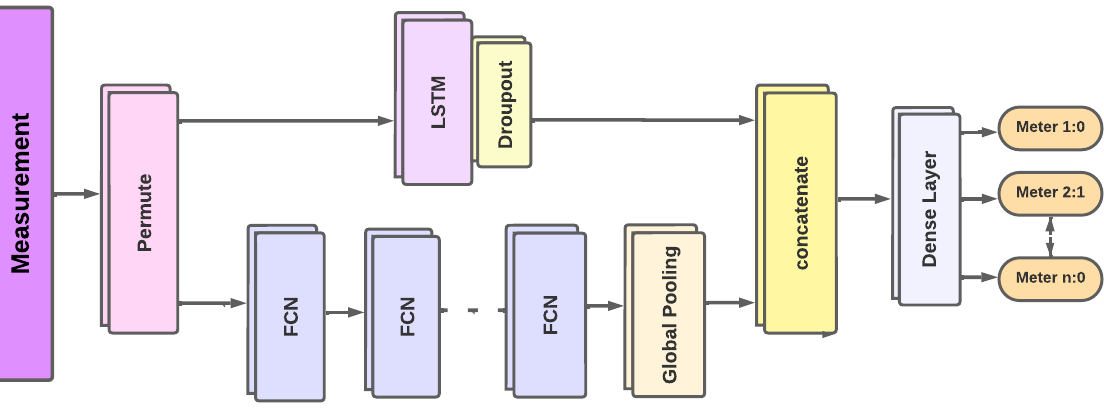
Figure 2. The architecture of LSTM-TCN. 1: compromised meter; 0: uncompromised